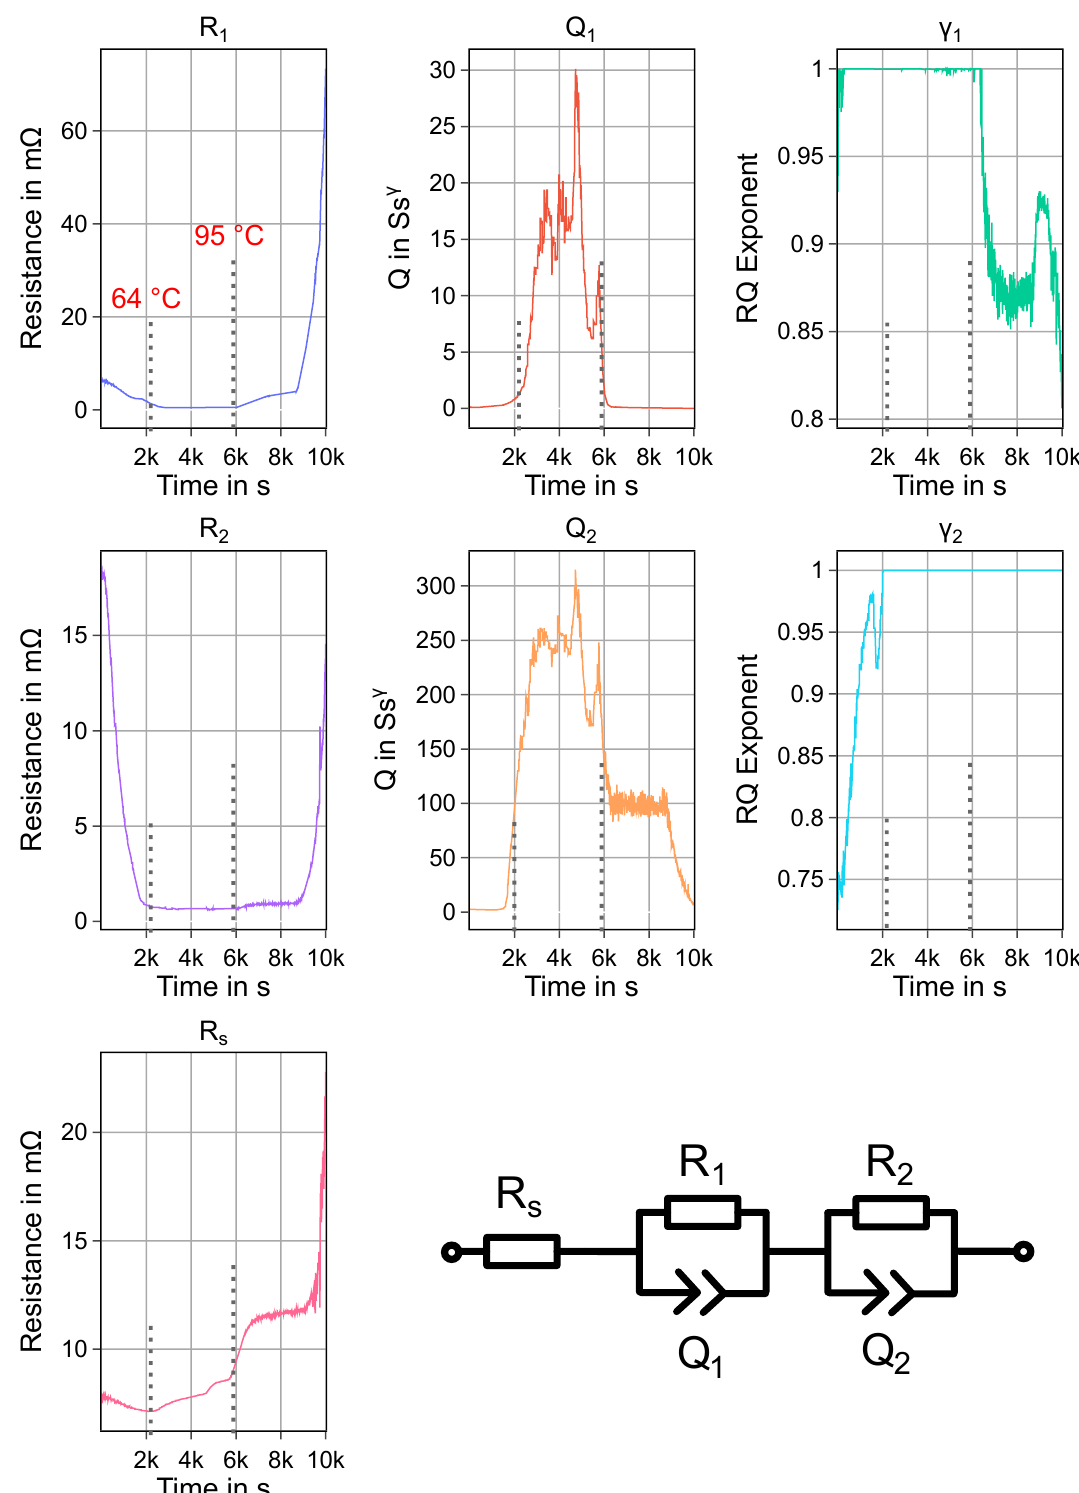
Figure A1. Used ECM (bottom right) and fitting results for impedance spectra of experiment HT2. The marked points in time and the respective temperature values of the cell correspond to the highlighted parts in Figure